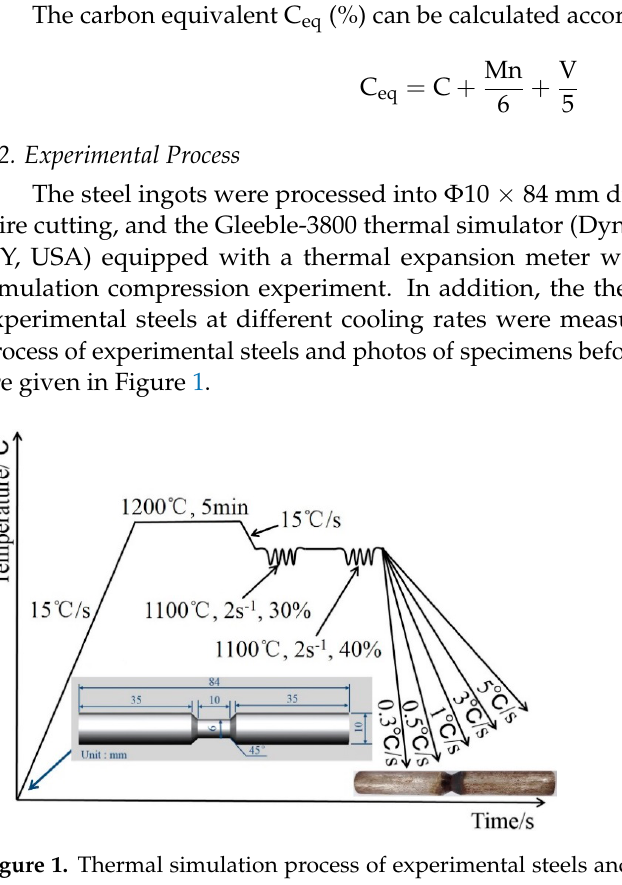
Figure 1. Thermal simulation process of experimental steels and photos of specimens before and after thermal simulation.